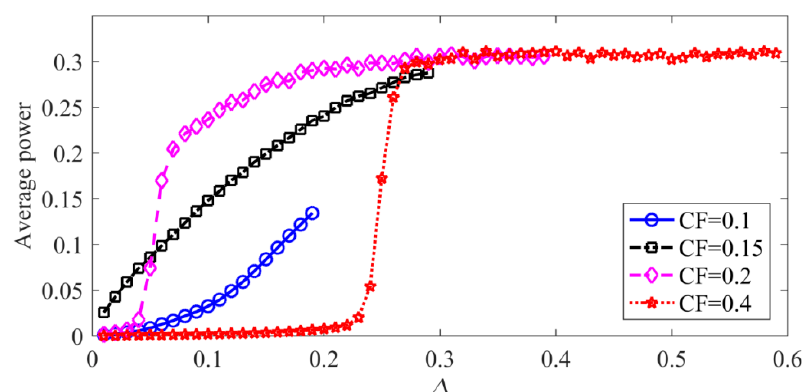
Figure 12. Influence of center frequency on the output performance of the asymmetric MEH excited by band-limited noise with different frequency bandwidth.